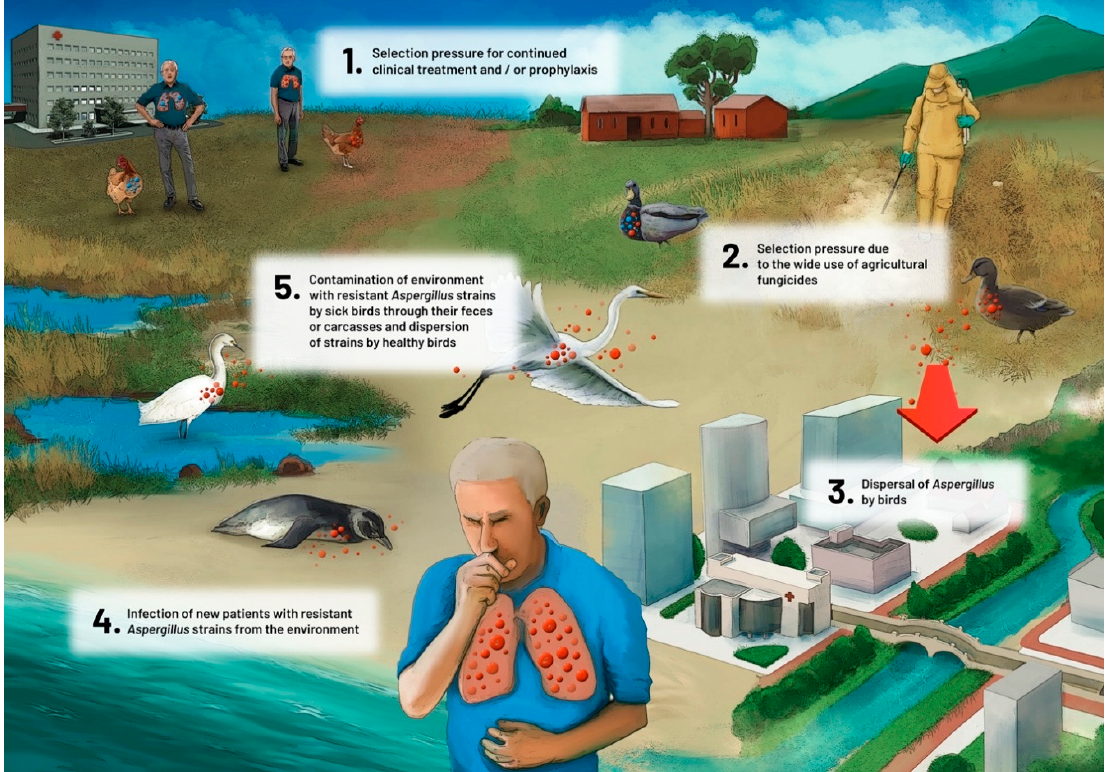
Figure 3. Proposed role of avian species in the dispersion of azole-resistant Aspergillus fumigatus.